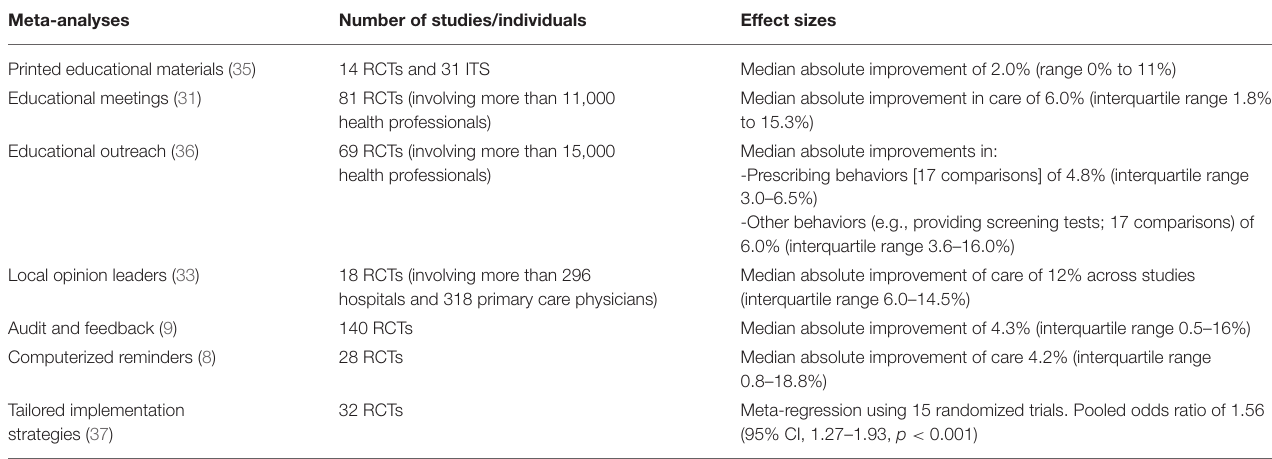
Table updated from Grimshaw et al. (34), and draws upon Cochrane Reviews from the Effective Practice and Organization of Care (EPOC) group (38).